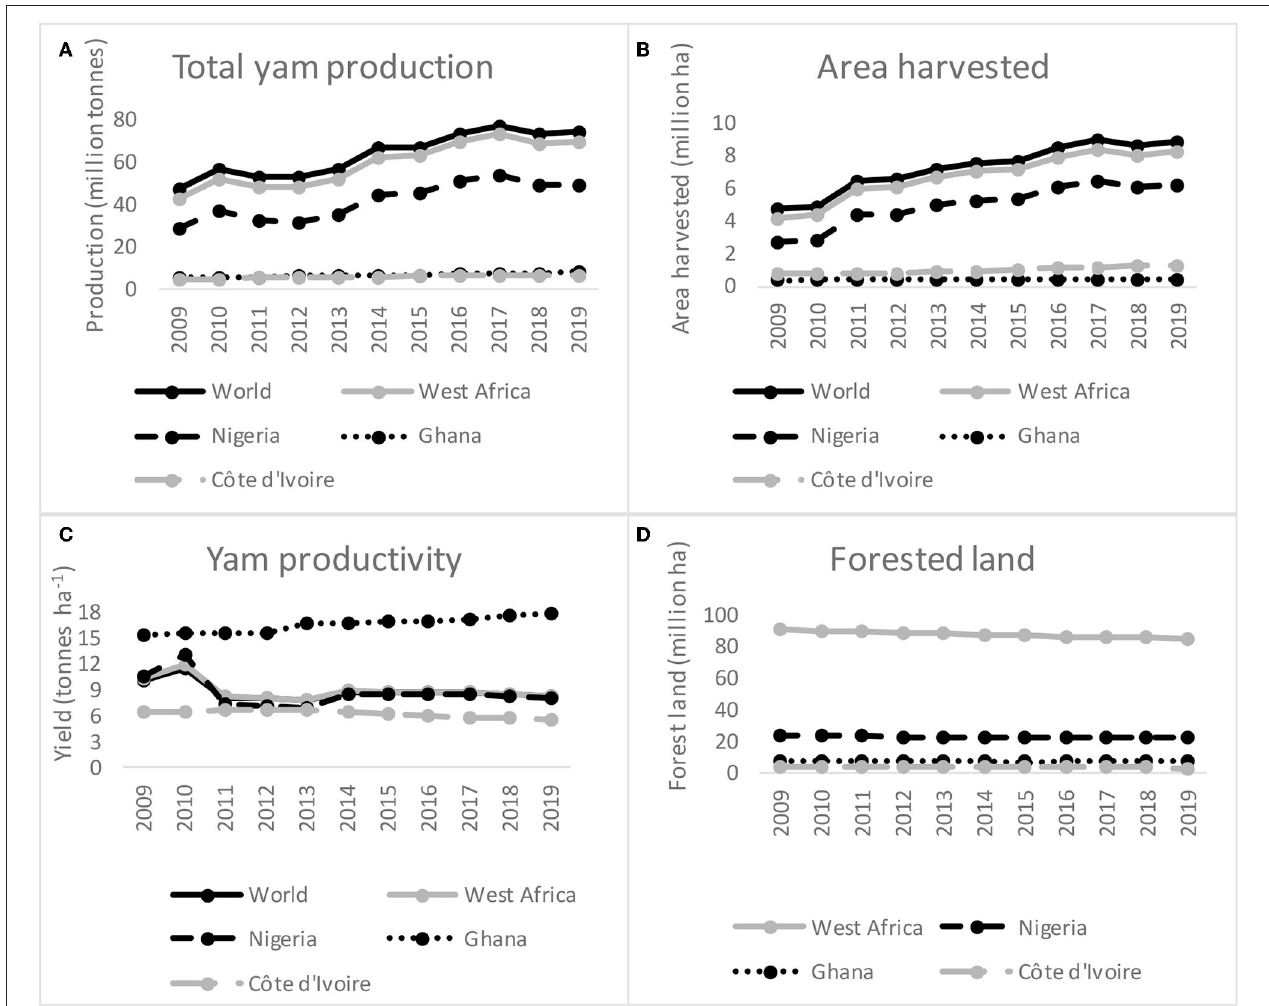
FIGURE 2 | Productivity indicators (A) production, (B) area harvested, (C) yield of yam, and (D) forest loss across the world, in West Africa, and in three leading yam-producing countries. The graphs were drawn from FAOSTAT